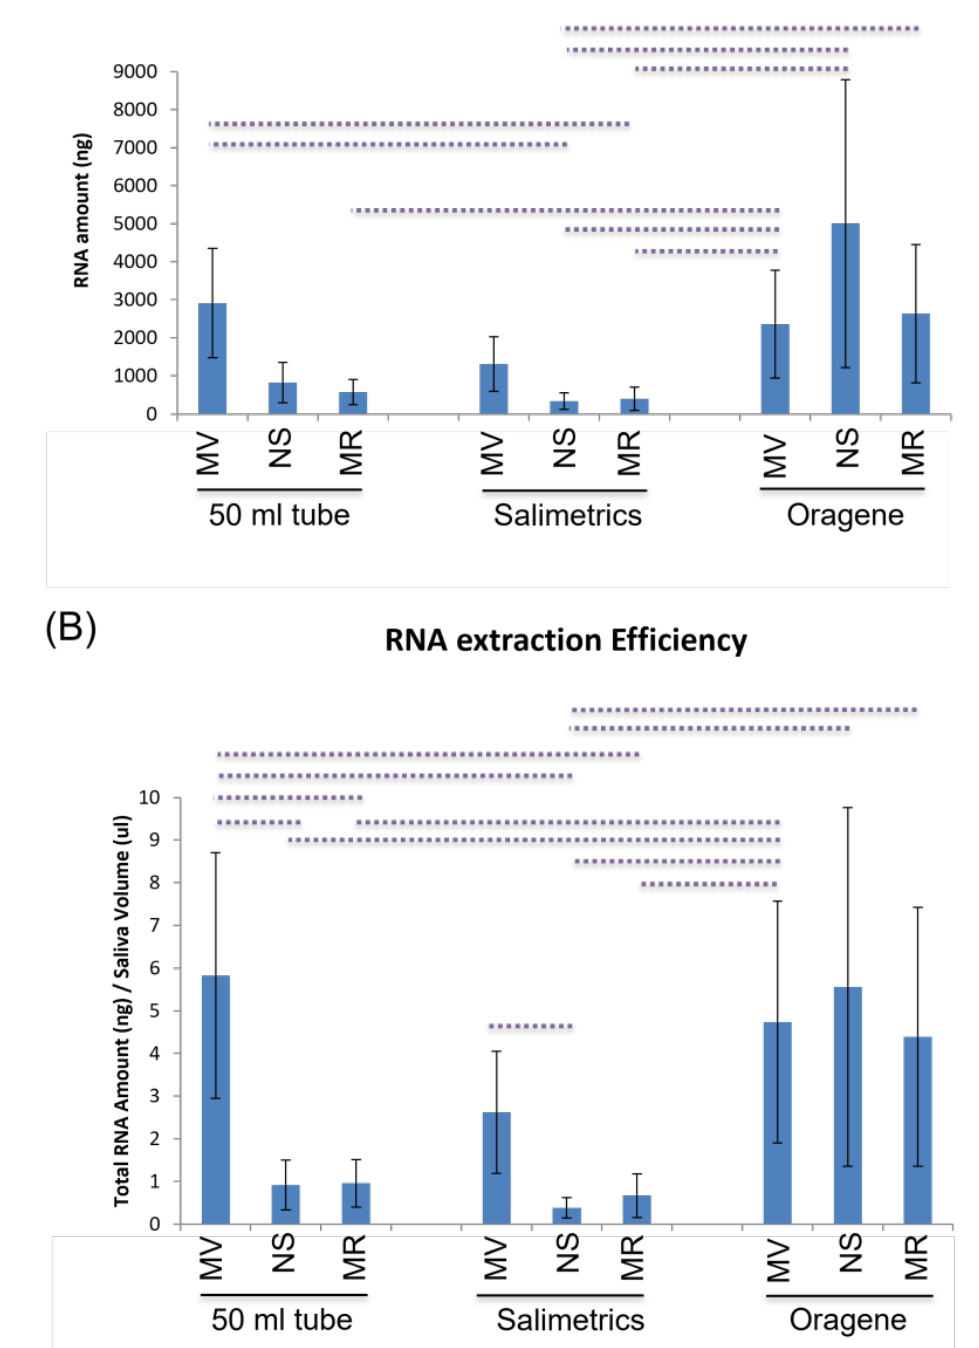
Figure 2. RNA purification amount and efficiency. Vertical bar chart shows the comparison between the combination of the three saliva collectors (50 mL tube, Salimetrics and Oragene) with three miRNA extraction kits, MV (mirVana miRNA isolation kit), NS (Nucleospin miRNA Plasma kit), MR (miRNeasy Serum/Plasma Advanced kit). ( A ) Amount of total RNA (in ng) isolated from whole saliva. ( B ) RNA extraction efficiency (ng of total RNA per µL of saliva used). Dashed lines represent significant differences ( p < 0.025).